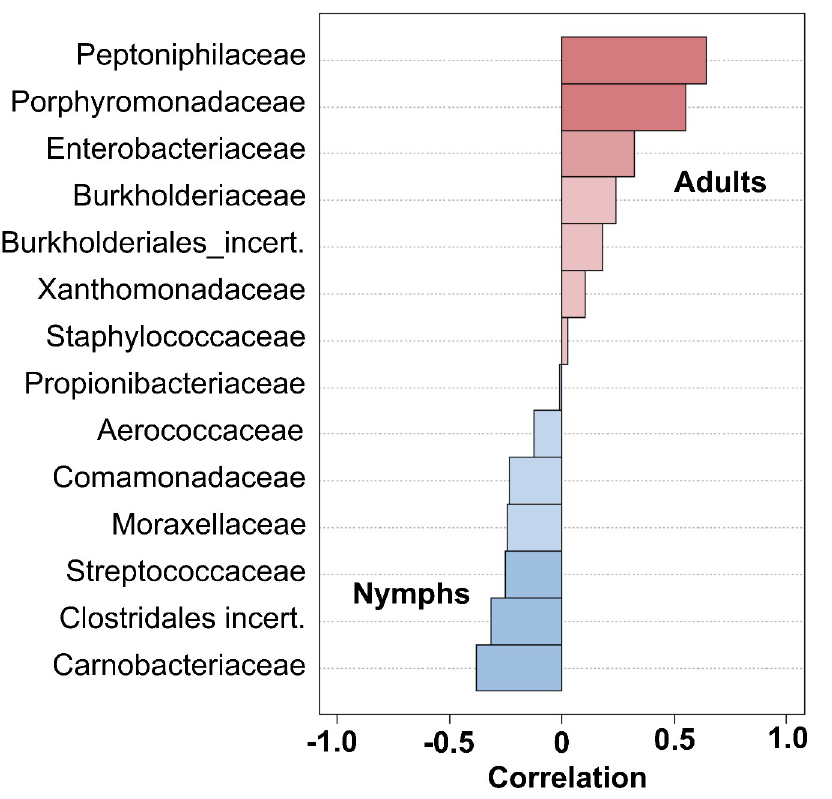
Fig 3. Correlation analysis of bacterial taxa with developmental stage. The association of bacterial taxa with developmental stage was assessed by sparCC correlation. Peptoniphilaceae, Porphyromonadaceae and to a lesser extent Enterobacteriaceae were significantly correlated with the field-caught adult microbiota, while Carnobacteriaceae, Clostridales incertae sedis, and Streptococcaceae were significantly correlated with laboratory-raised nymph microbiota ( P <